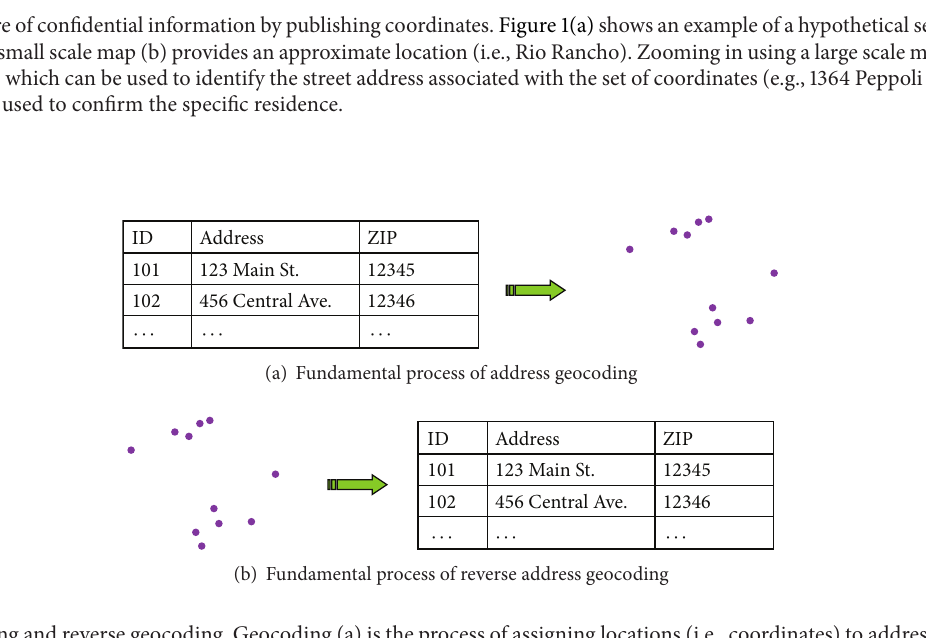
Figure 2: Geocoding and reverse geocoding. Geocoding (a) is the process of assigning locations (i.e., coordinates) to address information. A tabular dataset of addresses becomes a map. Reverse geocoding (b) literally puts this in reverse and converts mapped locations to addresses. Errors in the geocoding and reverse geocoding process may result in mismatched address information; that is, the addresses obtained using reverse geocoding may not be identical to those used in the original